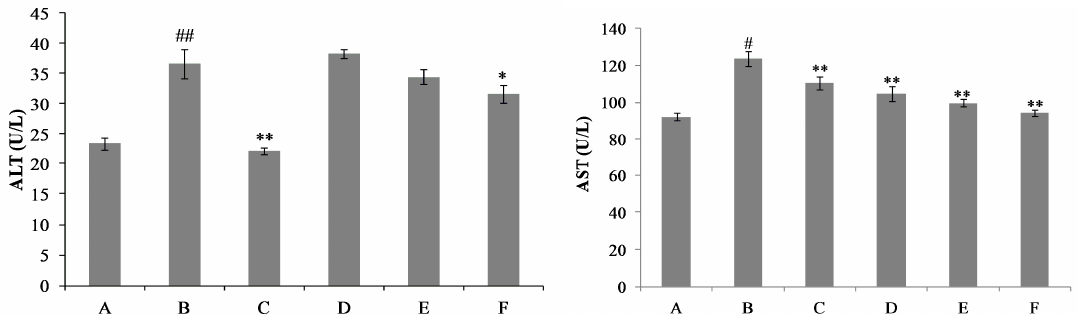
Figure 6. Effects of nicotiflorin on hepatic homogenate ALT and AST in D -GalN-intoxicated mice. (A) Control group; (B) D -GalN-treated group; (C) D -GalN and DDB (150 mg/kg bw)-treated group; (D) D -GalN and nicotiflorin (25 mg/kg bw)-treated group; (E) D -GalN and nicotiflorin (50 mg/kg bw)-treated group; and (F) D -GalN and nicotiflorin (100 mg/kg bw)-treated group. Values are mean ± S.E.M., n = 10. # p < 0.05, ## p < 0.01 compared with the control group. * p < 0.01, ** p < 0.01 compared with the D -GalN group.